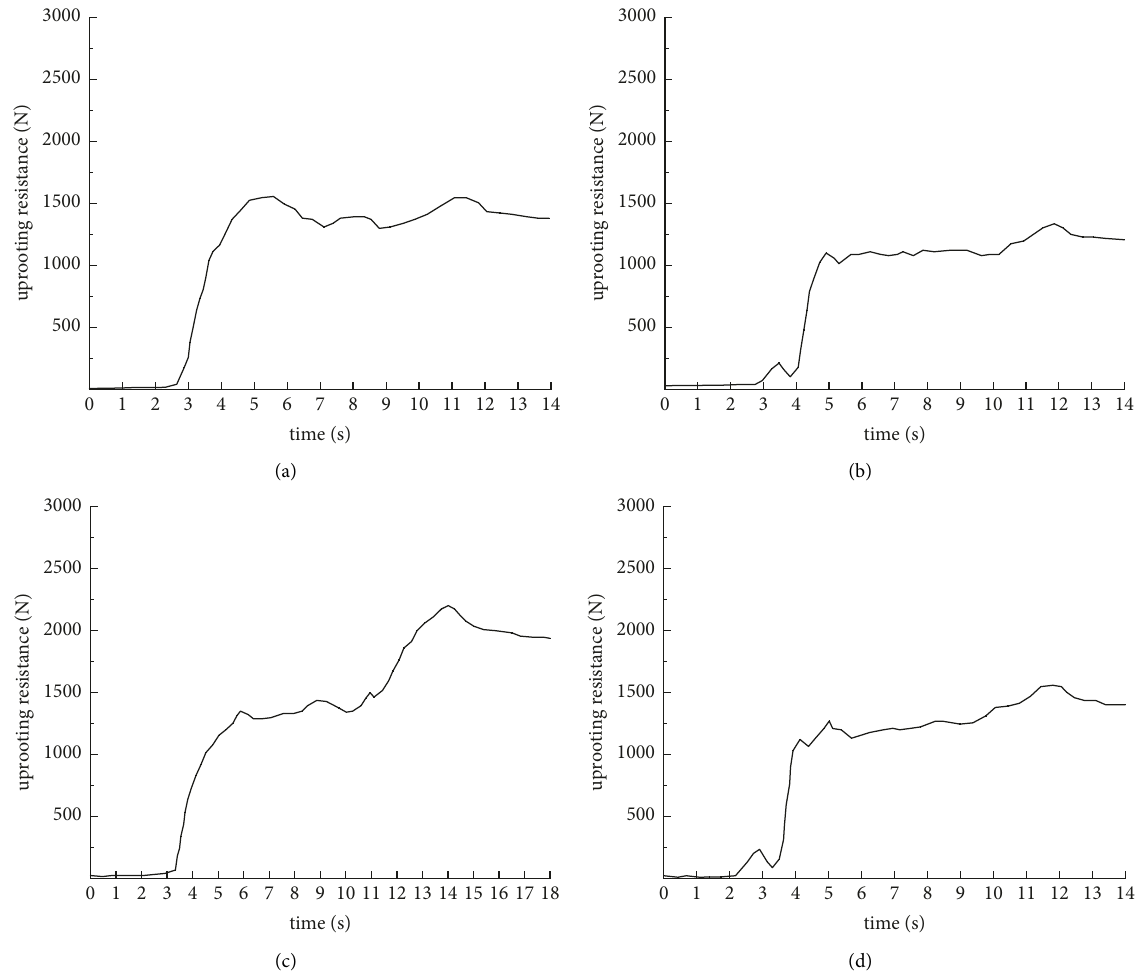
Figure 10: Sand matrix, single-layer stone test results. (a) Test 3-1. (b) Test 3-2. (c) Test 3-3. (d) Test 3-4.